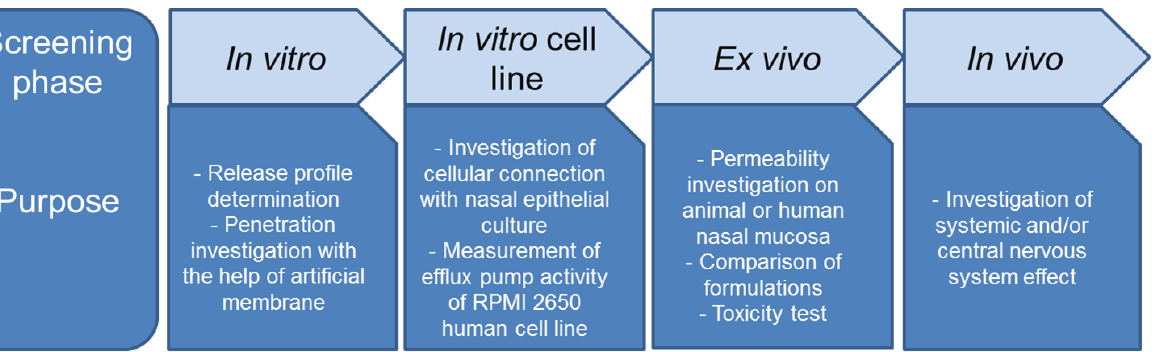
Figure 1. Suggested investigation protocol during formulation development of nasal formulations.